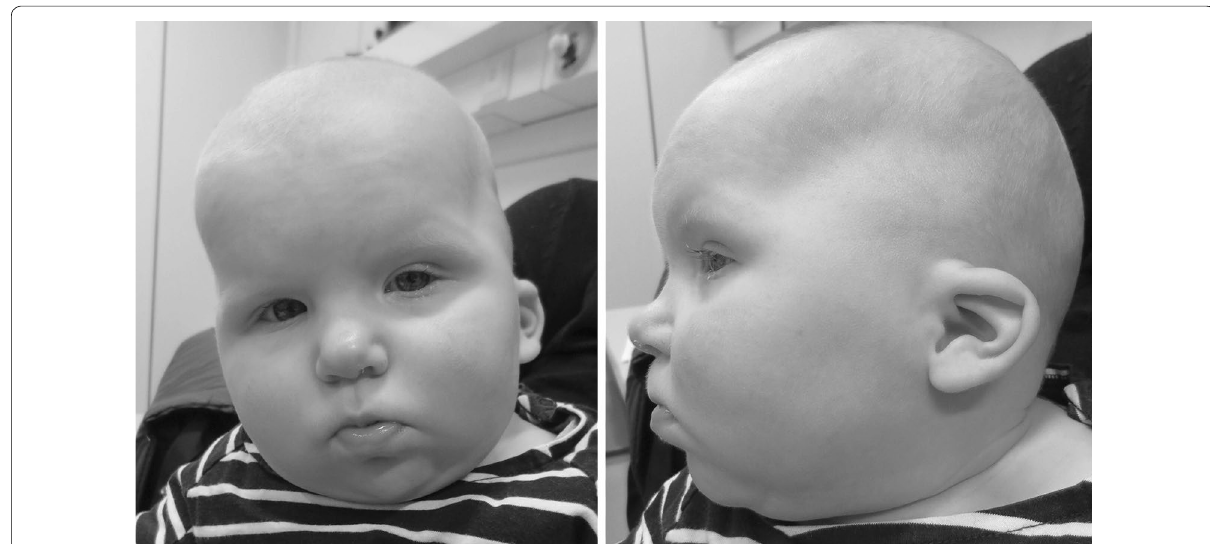
Fig. 1 Facial characteristics of the child with KAT6A mutation. Characteristic features of this syndrome, e.g. bitemoporal narrowing, broad nasal tip, low set ears, thin upper lip, micrognatia and smooth filtrum are